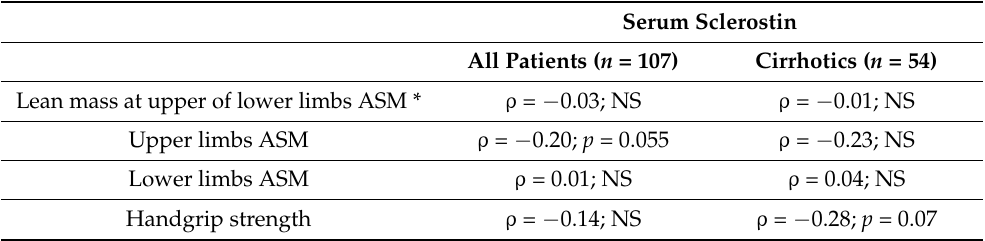
Table 2. Relationships between serum sclerostin and lean mass in all patients and considering only